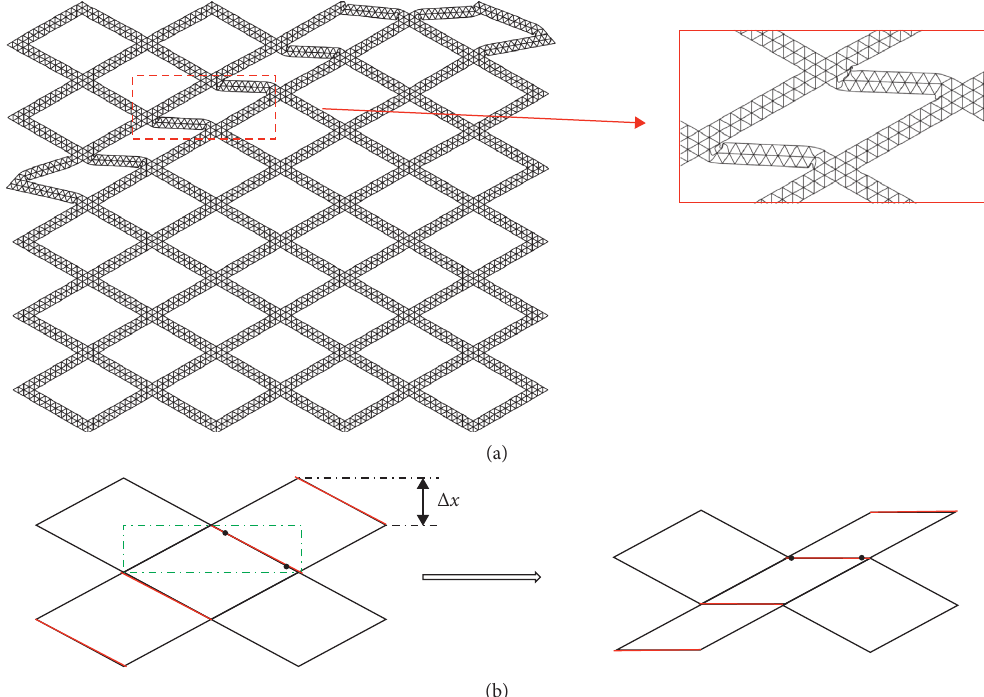
Figure 6: (a) Enlarged DHH deformation diagram, N � 12, ρ � 5%, and ε � 6%. (b) Schematic of the deformation of the subunits under impact loading in the x